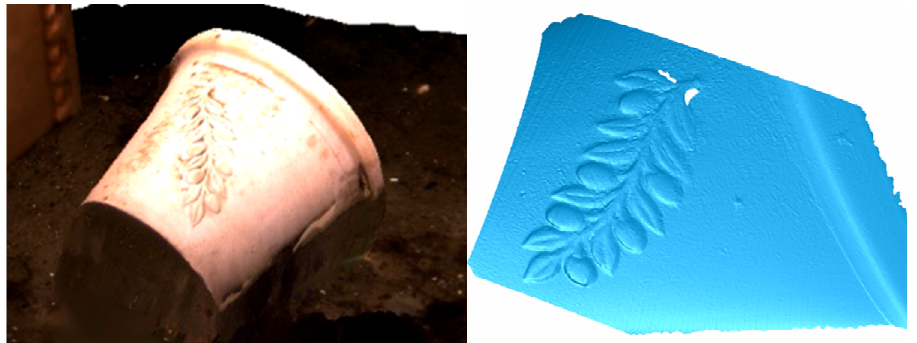
Figure 5. Detail on the pottery vessel from the visual odometry data ( left ) and structured illumination without color mapping ( right ).